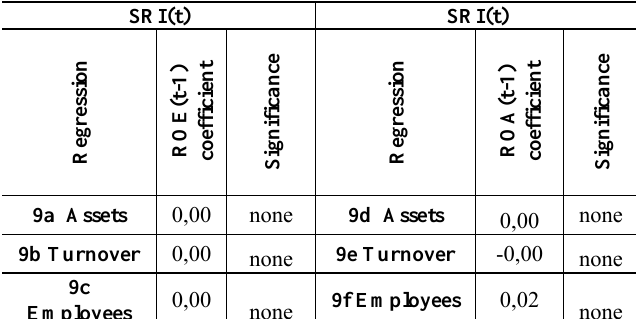
Table 8: Logistic regression following Waddock & Graves (1997) – using financial performance as a predictor of social